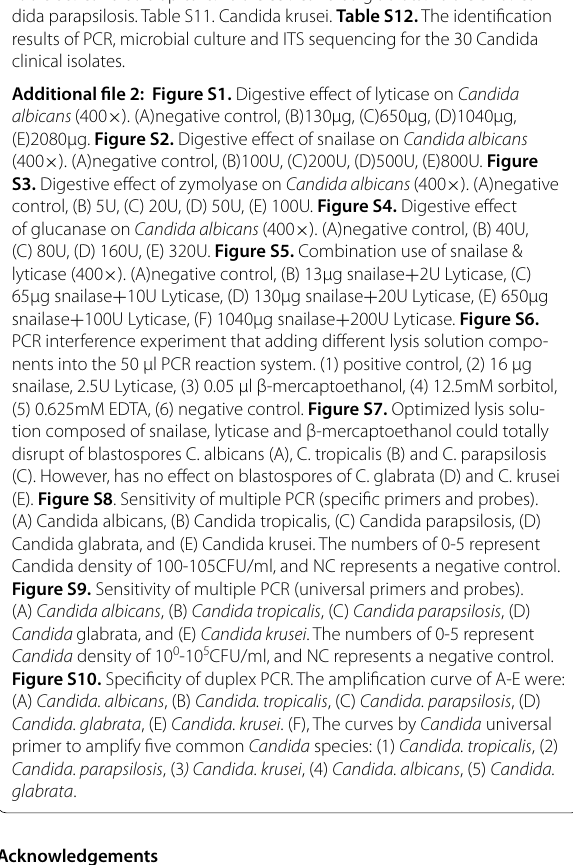
Table S8. Candida tropicalis. Table S9. Candida glabrata. Table S10. Can- dida parapsilosis. Table S11. Candida krusei. Table S12. The identification results of PCR, microbial culture and ITS sequencing for the 30 Candida clinical isolates.